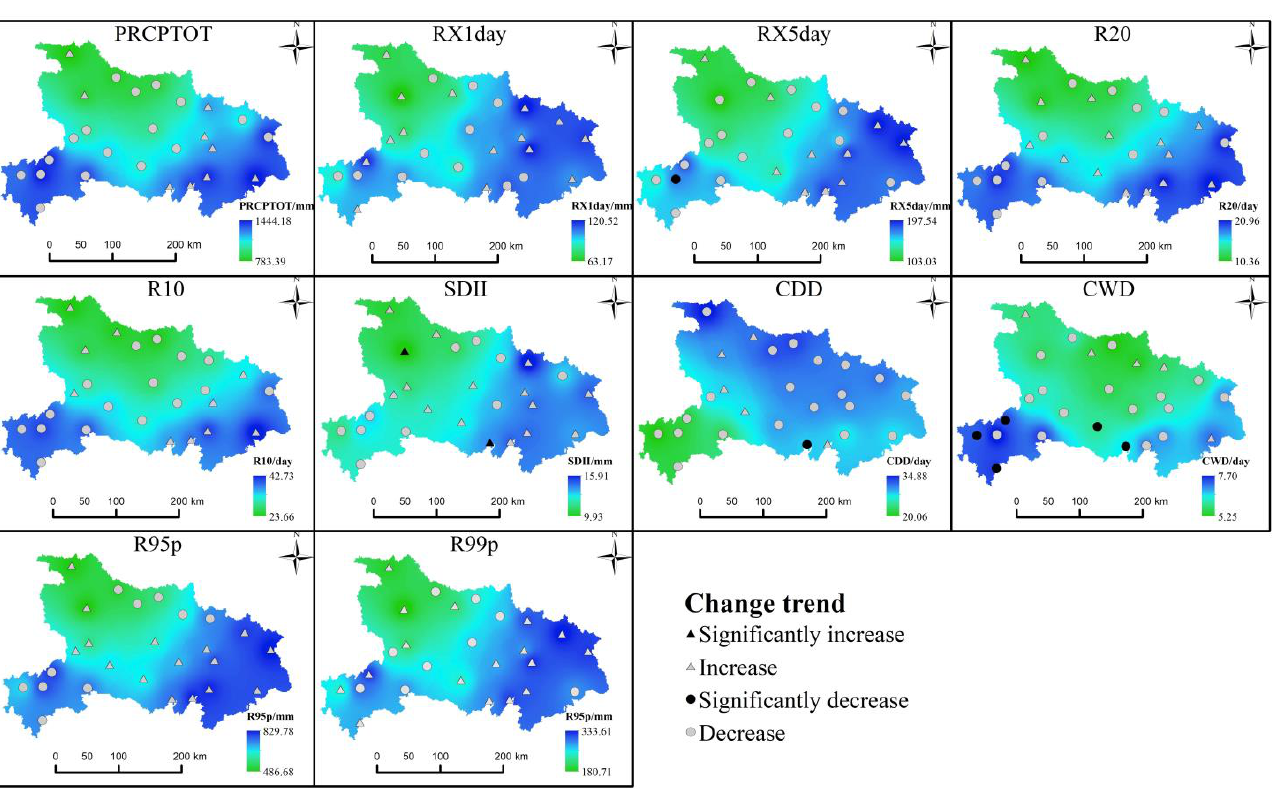
Figure 4. Spatial variations of annual average EPIs and the changing trend of annual EPIs for each station within the Hubei province.